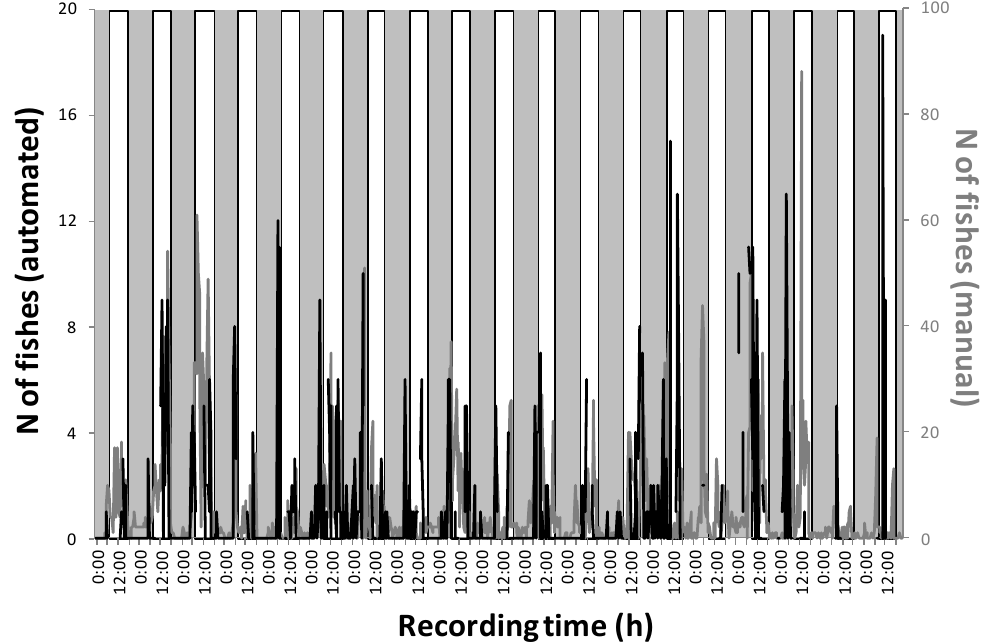
Figure 6. Time series outputs for automated (black) and manual (grey) time series in fish video counts as obtained continuously at day and night-time, with 30 min time-lapse photographic frequency sampling carried out during one month at the OBSEA cabled observatory.